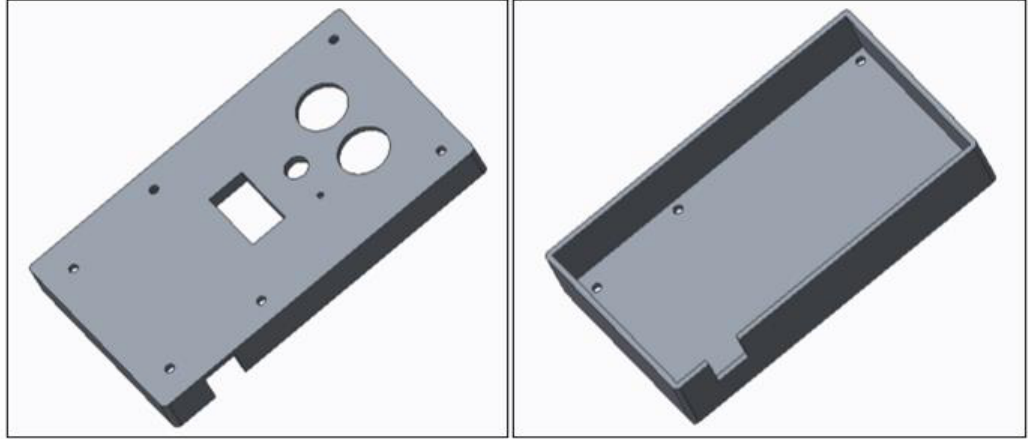
Figure 5. Enclosure CAD model for the body temperature screening system.